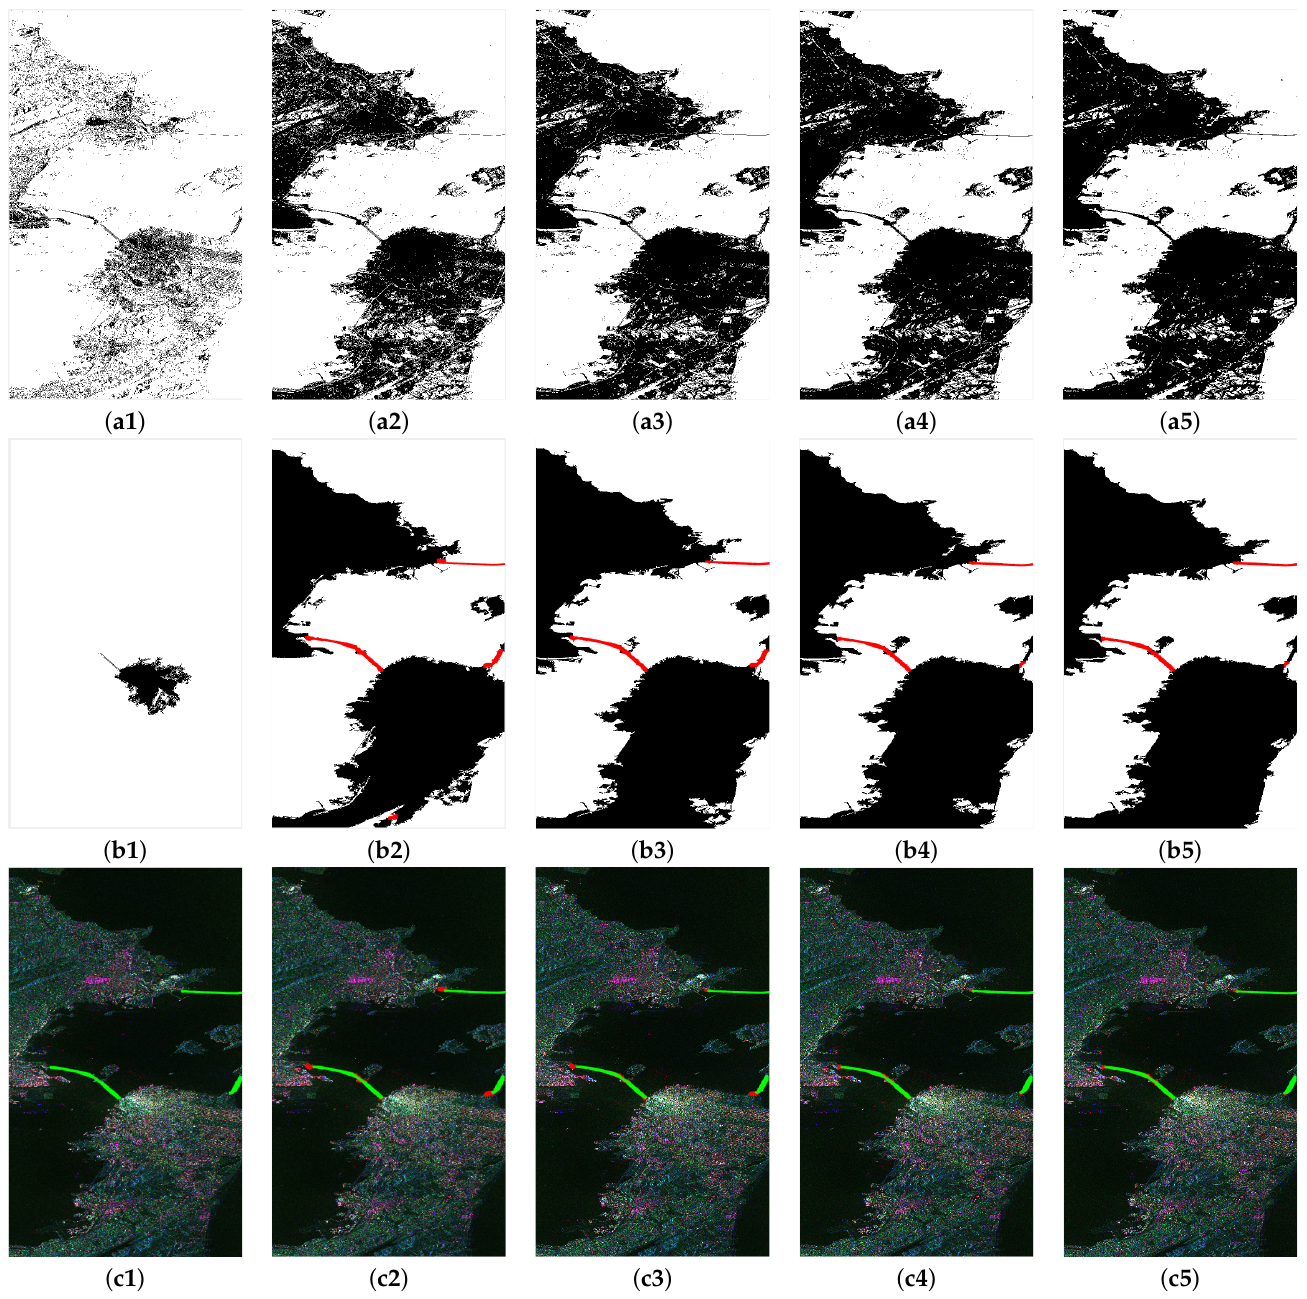
Figure 7. Performance comparison of the TerraSAR-X San Francisco data using the windowed level set segmentation under different window sizes. ( a1 – a5 ) The level set segmentation results. ( b1 – b5 ) The segmentation results after water merging and the detection results of the region of interest of the bridge. ( c1 – c5 ) The results of bridge recognition. ( a i – c i ) The detection results when the window sizes are 1, 3, 5, 7, and 9,